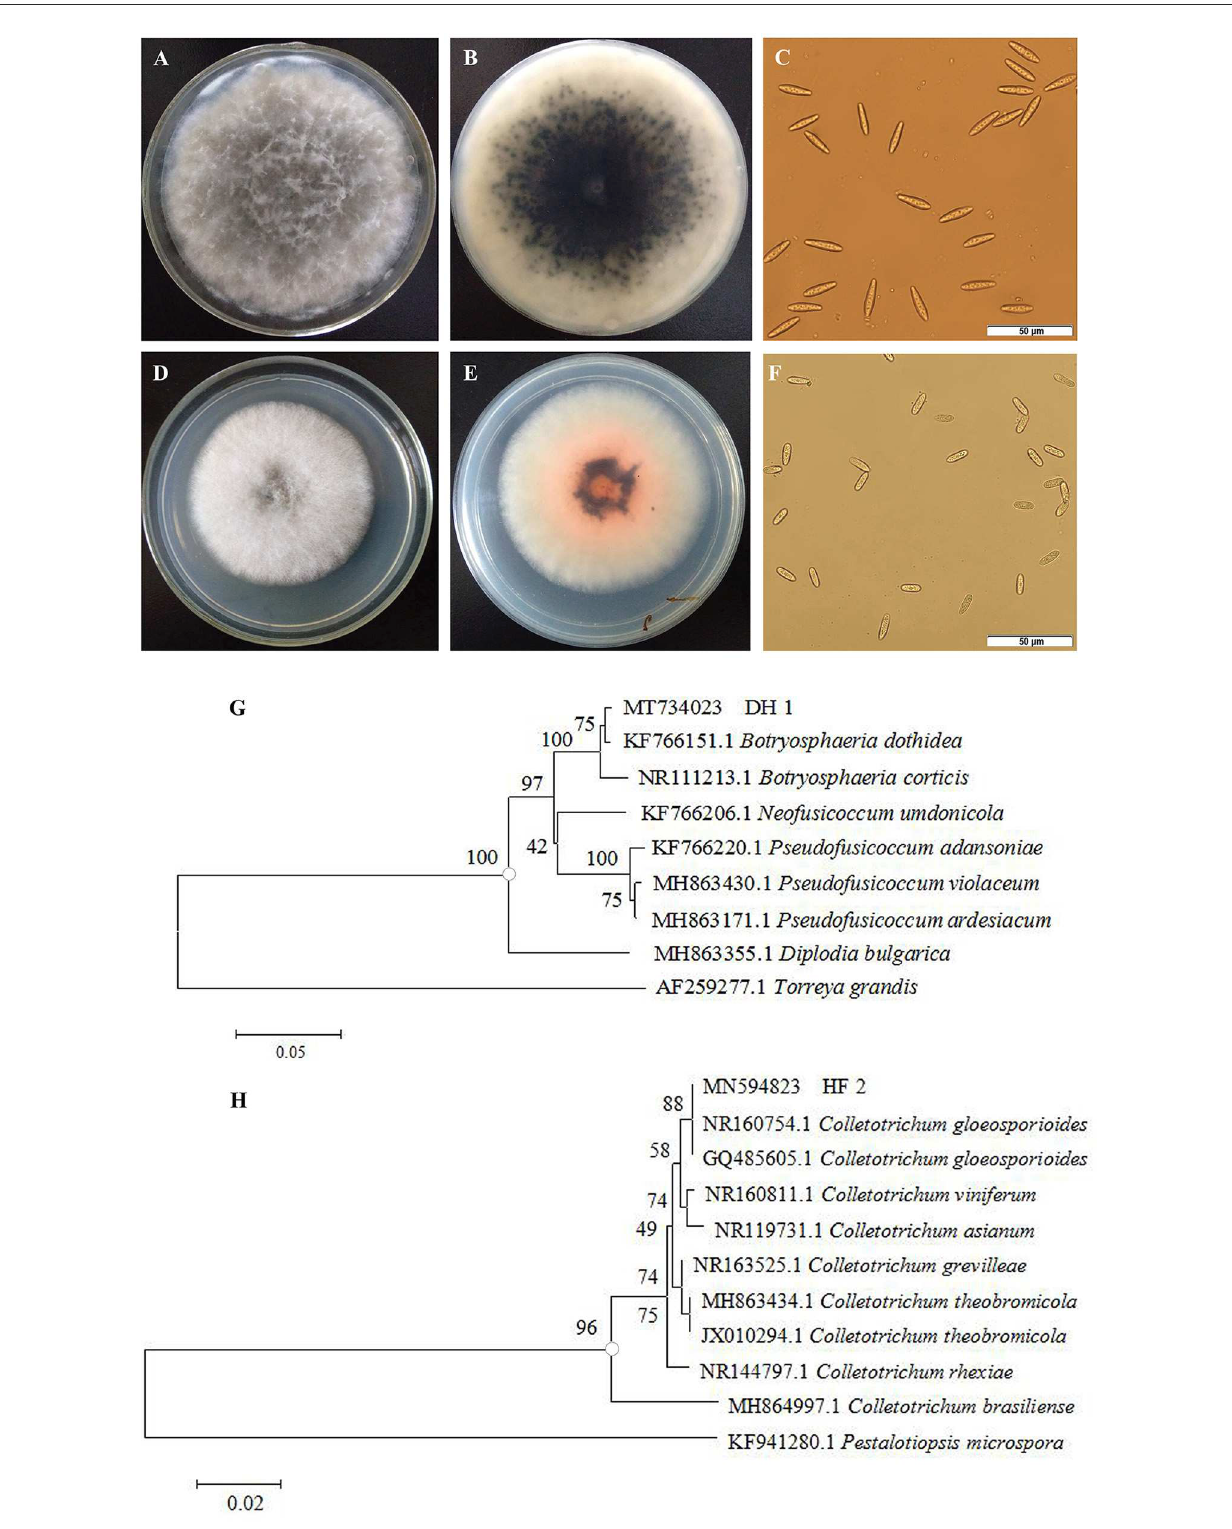
FIGURE2 Morphological characteristics and phylogenetic tree of isolated pathogens. Colonies of pathogen DH1 (A, B) and HF2 (D, E) . Spores of pathogen DH1 (C) and HF2 (F) . Phylogenetic analysis of rDNA-ITS sequences obtained from the isolate DH1 (G) and HF2 (H) along with the reference sequences from